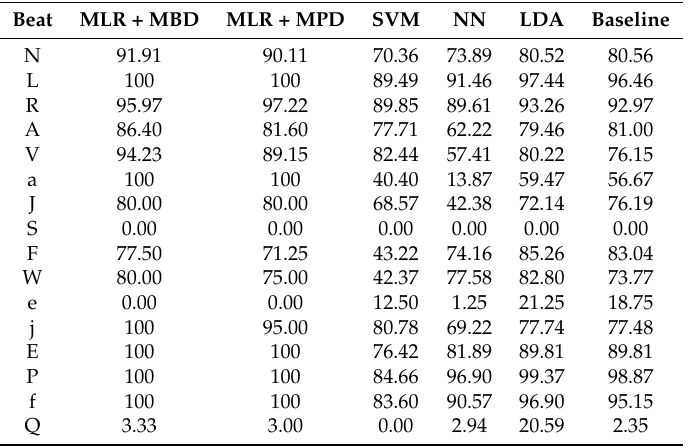
Table 6. Method performance for each beat class on MLV.